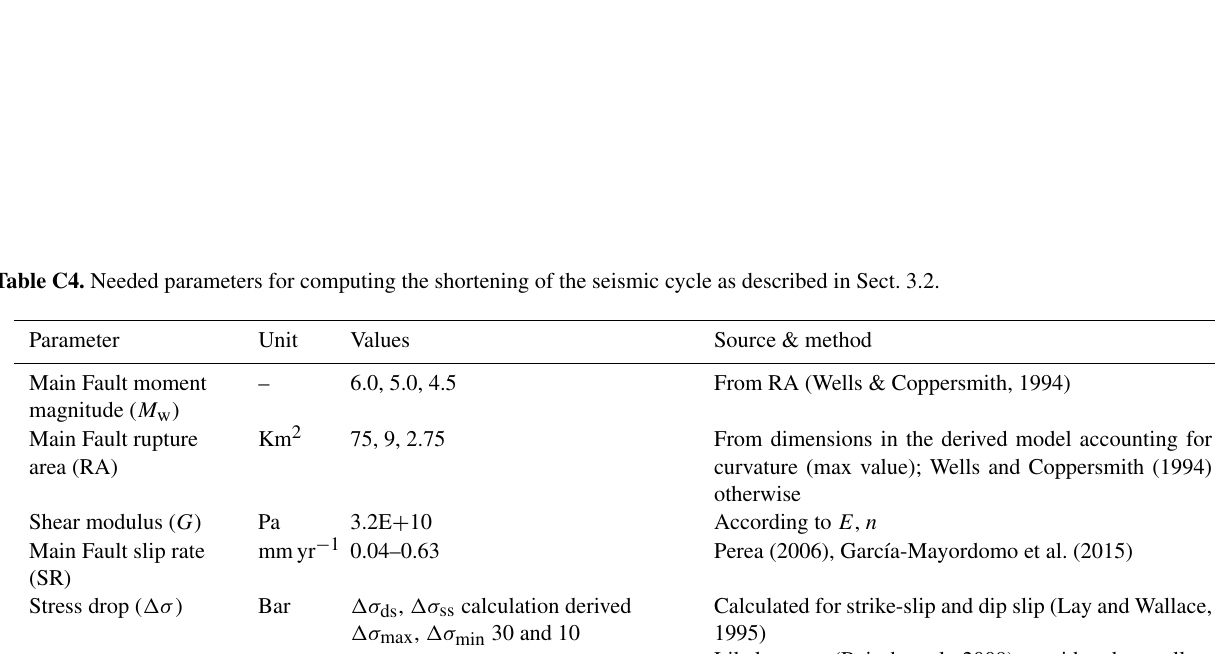
curvature (max value); Wells and Coppersmith (1994) otherwise Calculated for strike-slip and dip slip (Lay and Wallace,